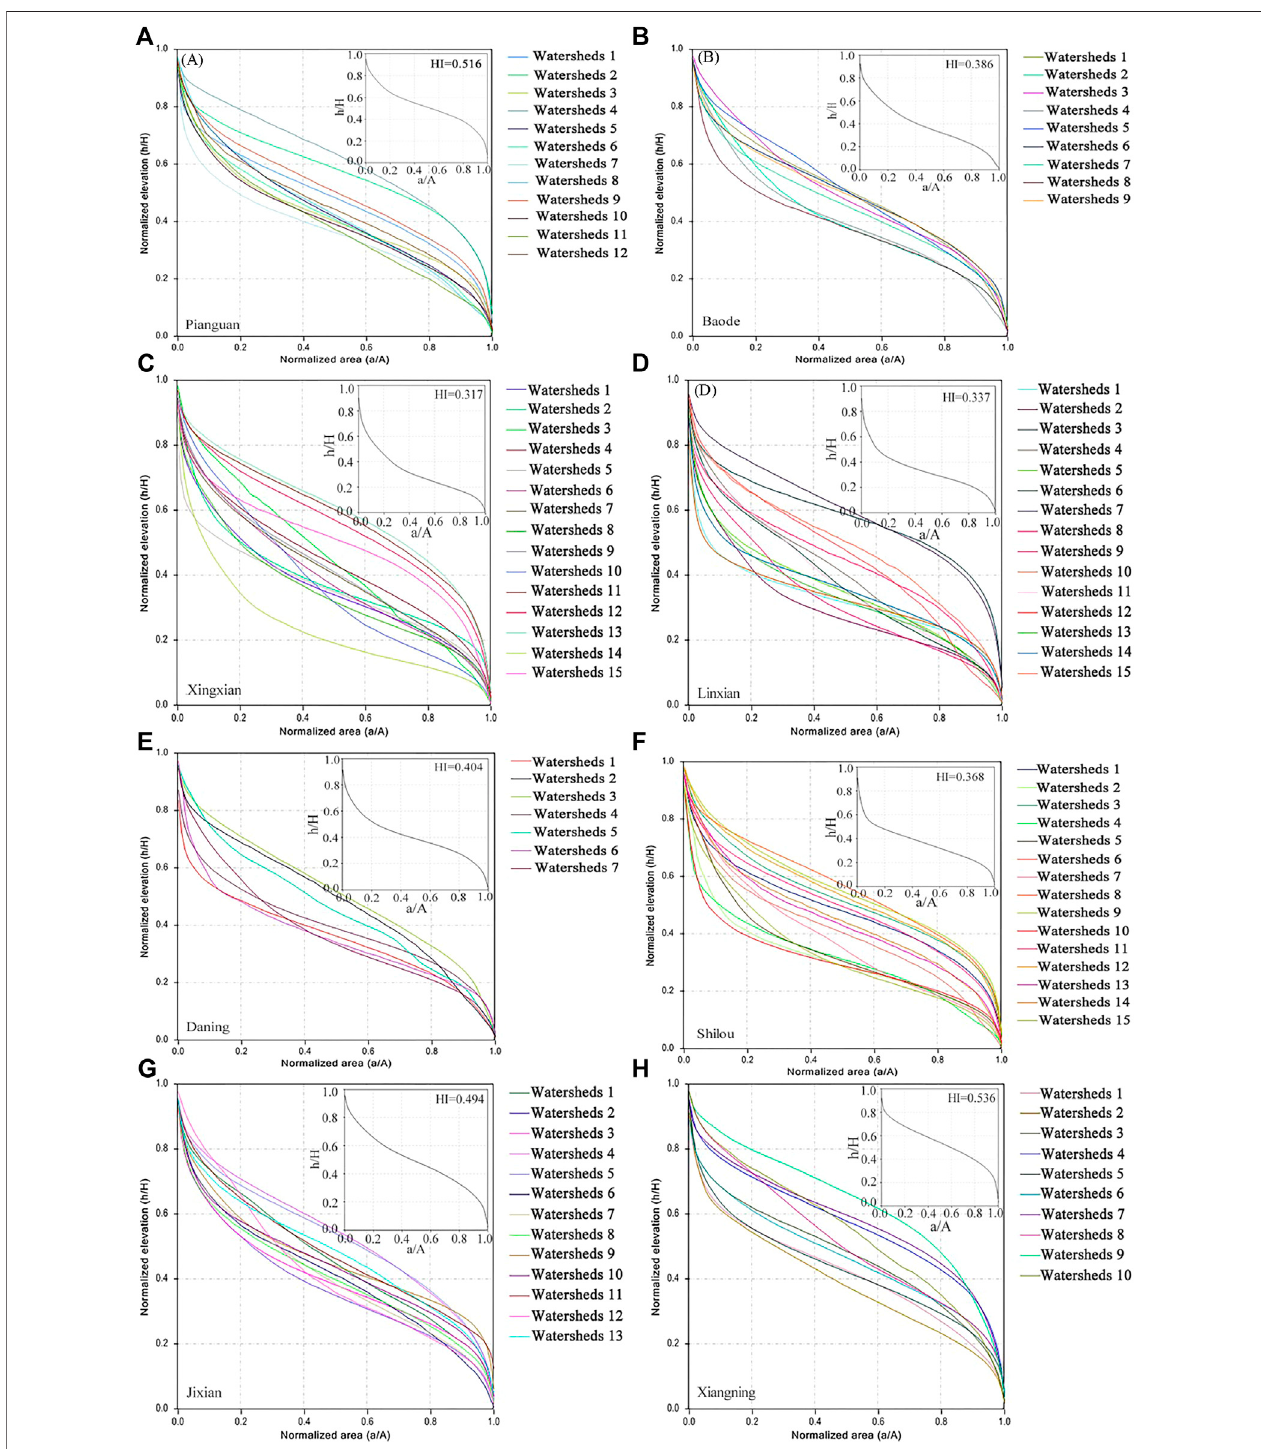
FIGURE 5 | Hypsometric integral (HI) curves of sub-watersheds in each plot: (A) Pianguan, (B) Baode, (C) Xingxian, (D) Linxian, (E) Daning, (F) Shilou, (G) Jixian, (H) Xiangning.